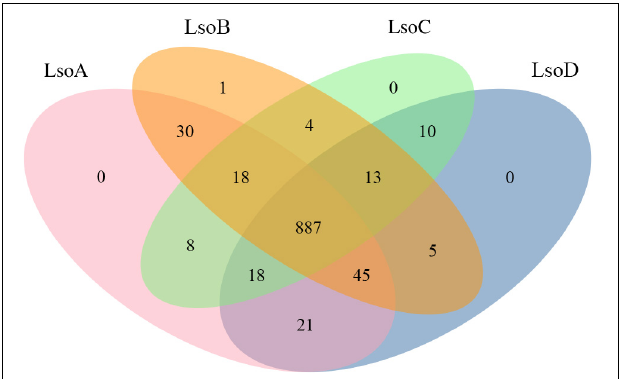
FIGURE 3 | Orthologous clustering of Lso haplotypes determined using OrthoFinder are represented as a Venn diagram. The values indicate the number of orthologous protein